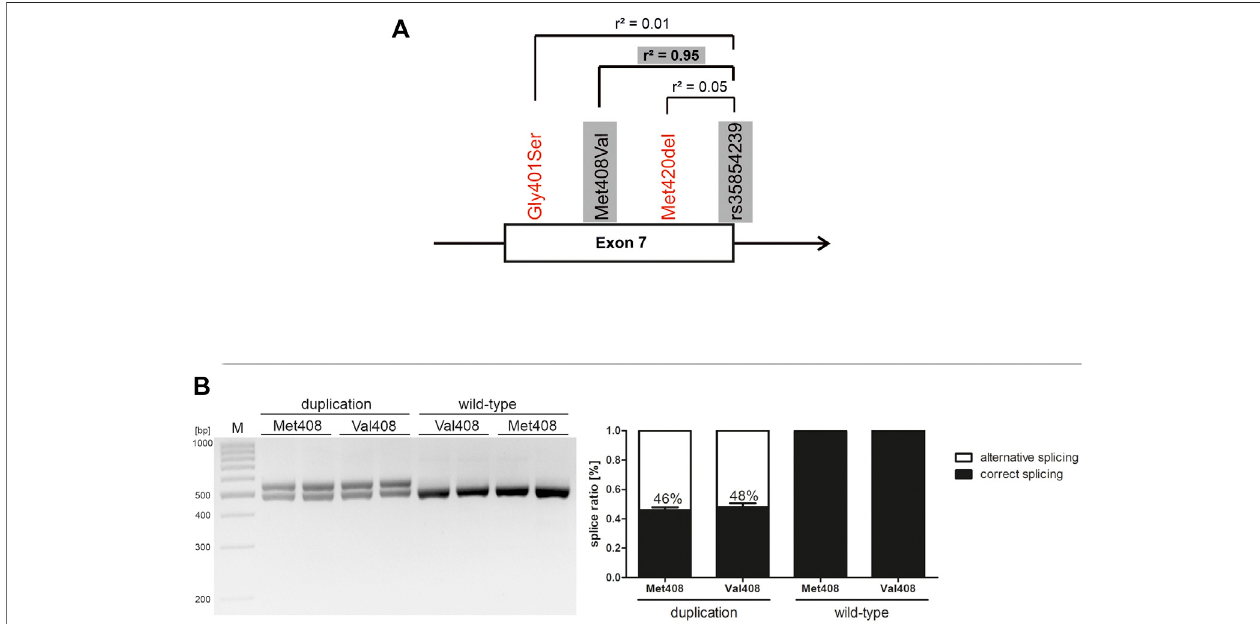
FIGURE 2 | Effects of Met408Val on rs35854239 and on exon 7 splicing (A) Localization of rs35854239 at the exon 7-intron 7 junction of the SLC22A1 gene. Known variants reducing OCT1 function in exon 7 of the SLC22A1 gene are shown in red. The highly genetically linked variants that are separately analyzed here are highlighted in gray (B) The Met408Val polymorphism was introduced by site-directed mutagenesis into both minigenes: harboring the wild-type and the duplication alleles of rs35854239. After transient transfection in Huh7 cells, spliced transcripts were ampli fi ed and separated by gel electrophoresis and afterwards, band intensities of correctly and alternatively spliced transcripts were quanti fi ed. Percentages within boxes represent relative values of correctly spliced minigene. Shown are means and standard errors of the means of three independent